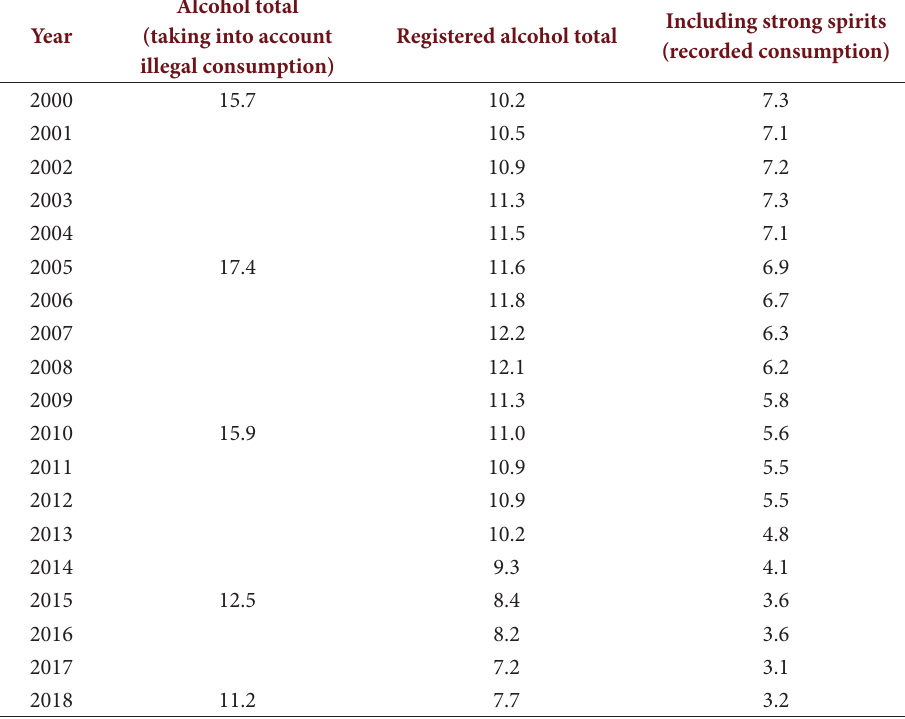
Table 2. Per capita alcohol consumption estimated for population aged 15 and over, liters of pure alcohol Alcohol total Including strong spirits Year (taking into account Registered alcohol total (recorded consumption) illegal consumption) 2000 15.7 10.2 7.3 2001 10.5 7.1 2002 10.9 7.2 2003 11.3 7.3 2004 11.5